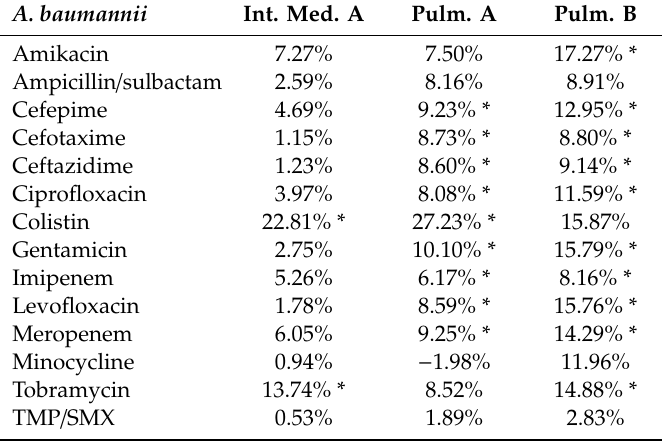
Table A6. Mean di ff erences of resistance rates for A. baumannii in ICUs versus other wards per antibiotic during the 2 years (2017–2018).